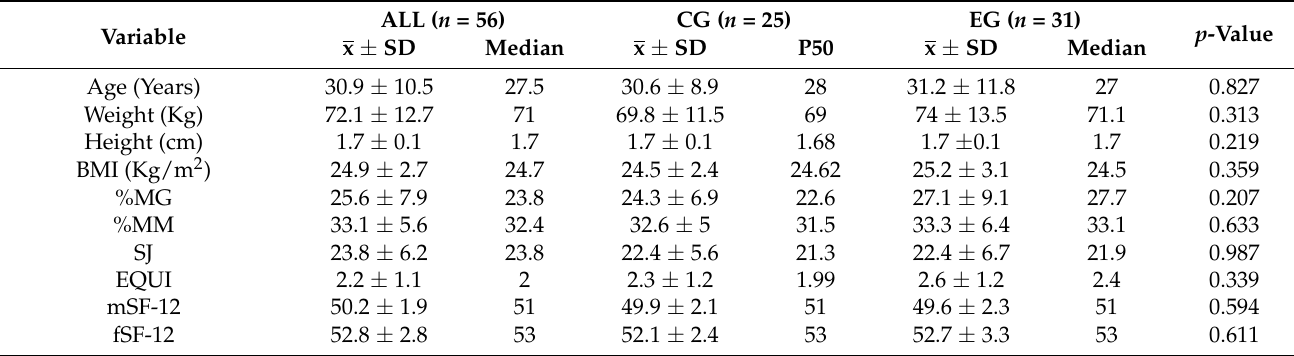
Table 2. Baseline of the studied